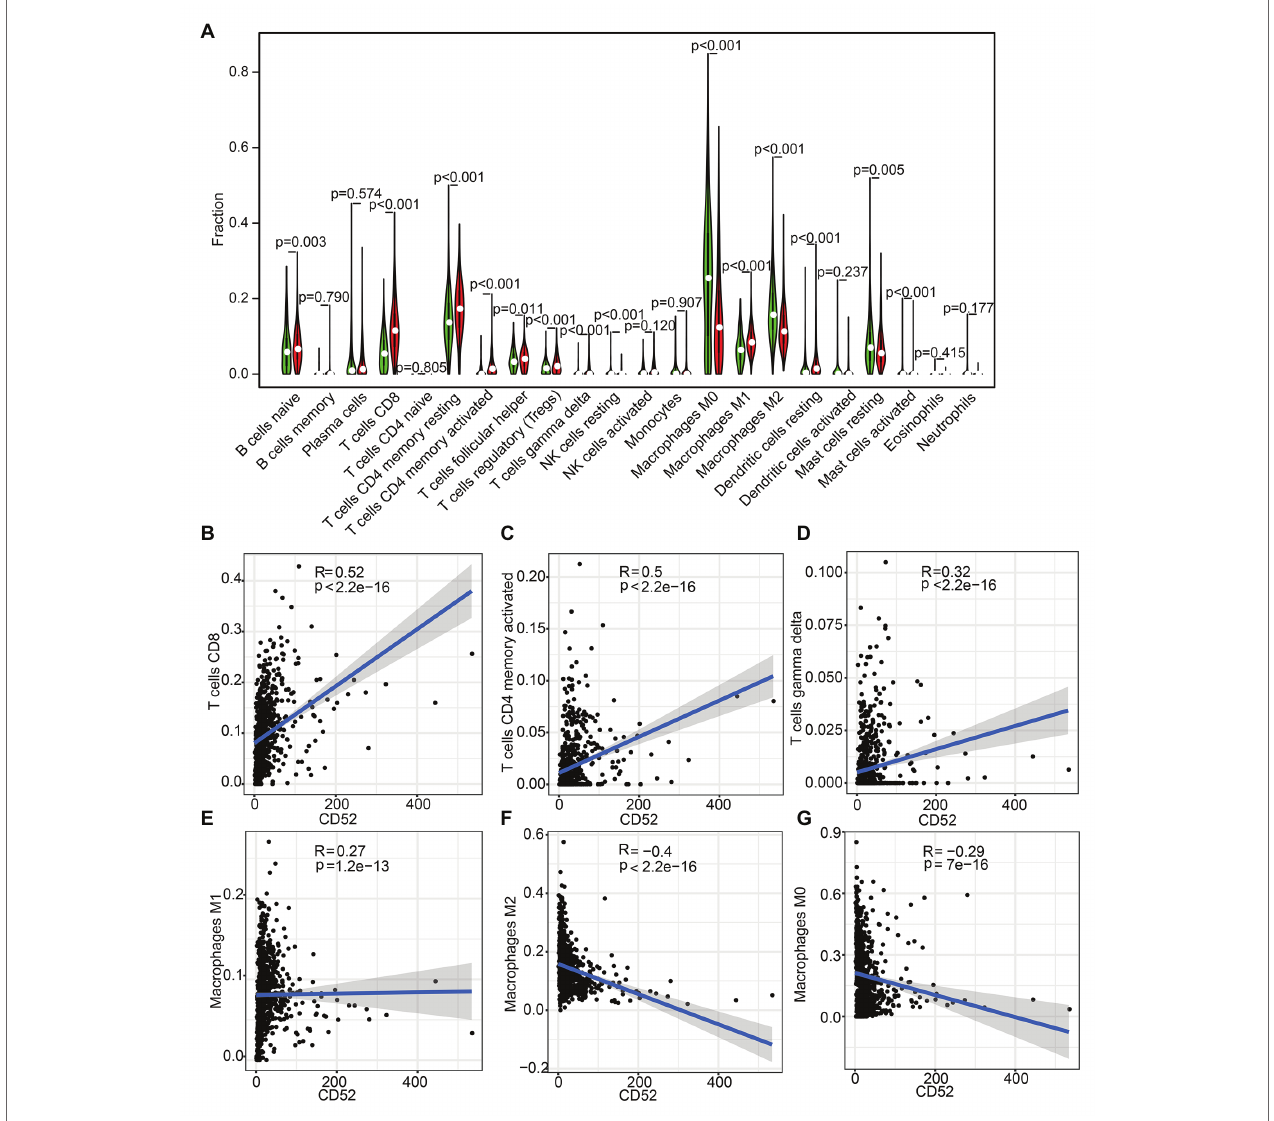
FIGURE 5 | Tumor-infiltrating immune cell (TIC) profile in tumor samples and correlation analysis. (A) The Violin plot showed a correlation between CD52 and TICs. (B–G) The Scatter plot showed the Pearson’s correlation of the most significant cell infiltration with the CD52